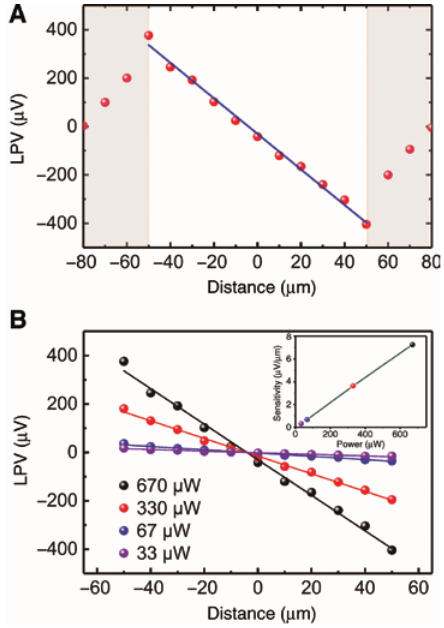
Figure 4: Lateral photovoltaic effect for the laser-scribed rGO devices: (A) LPV at different positions of laser spots (633 nm) and (B) LPV between the two Au electrodes with different laser powers. The inset is the sensitivity at different laser